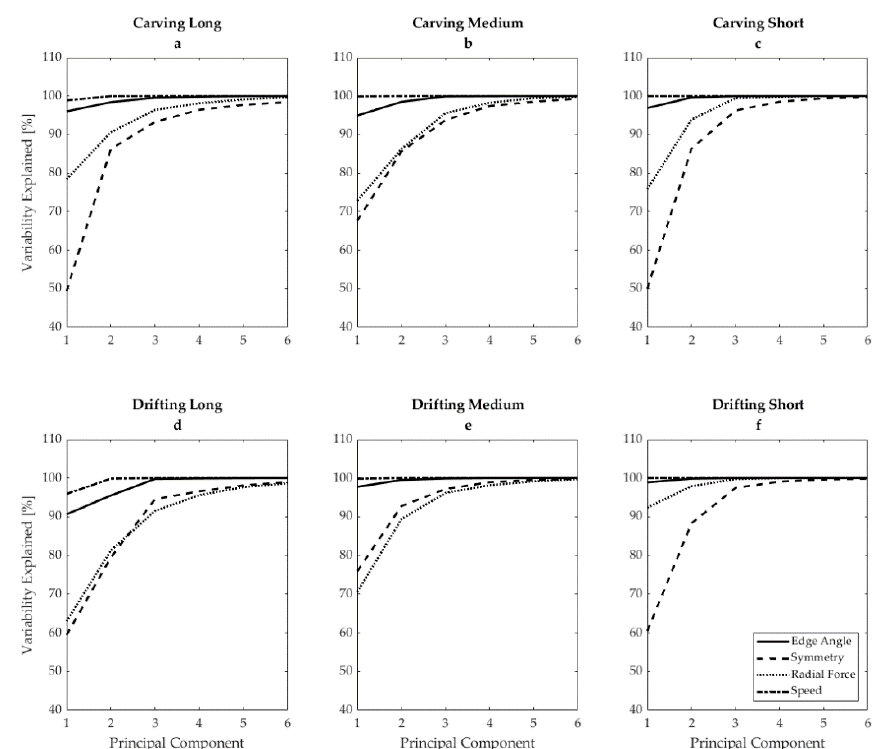
Figure 2. Cumulative explained variability of the first six principal components from the reference dataset for edge angle (solid line), edging symmetry (dashed line), radial force (dotted line), and speed (dot–dash line), in ( a ) carving long radius, ( b ) carving medium radius, ( c ) carving short radius, ( d ) drifting long radius, ( e ) drifting medium radius, and ( f ) drifting short radius.